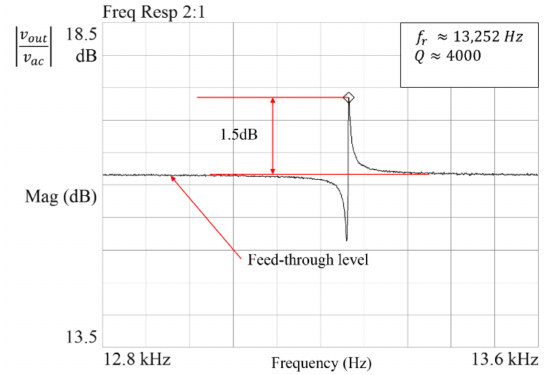
Figure 2. Typical frequency response of a MEMS